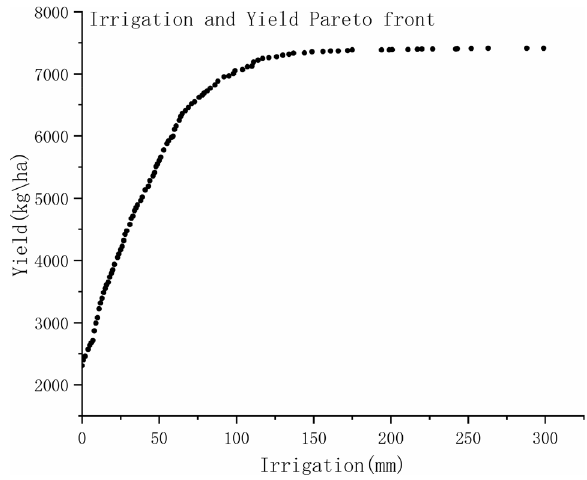
Figure 4. Applied the actual irrigation date to optimize yield and